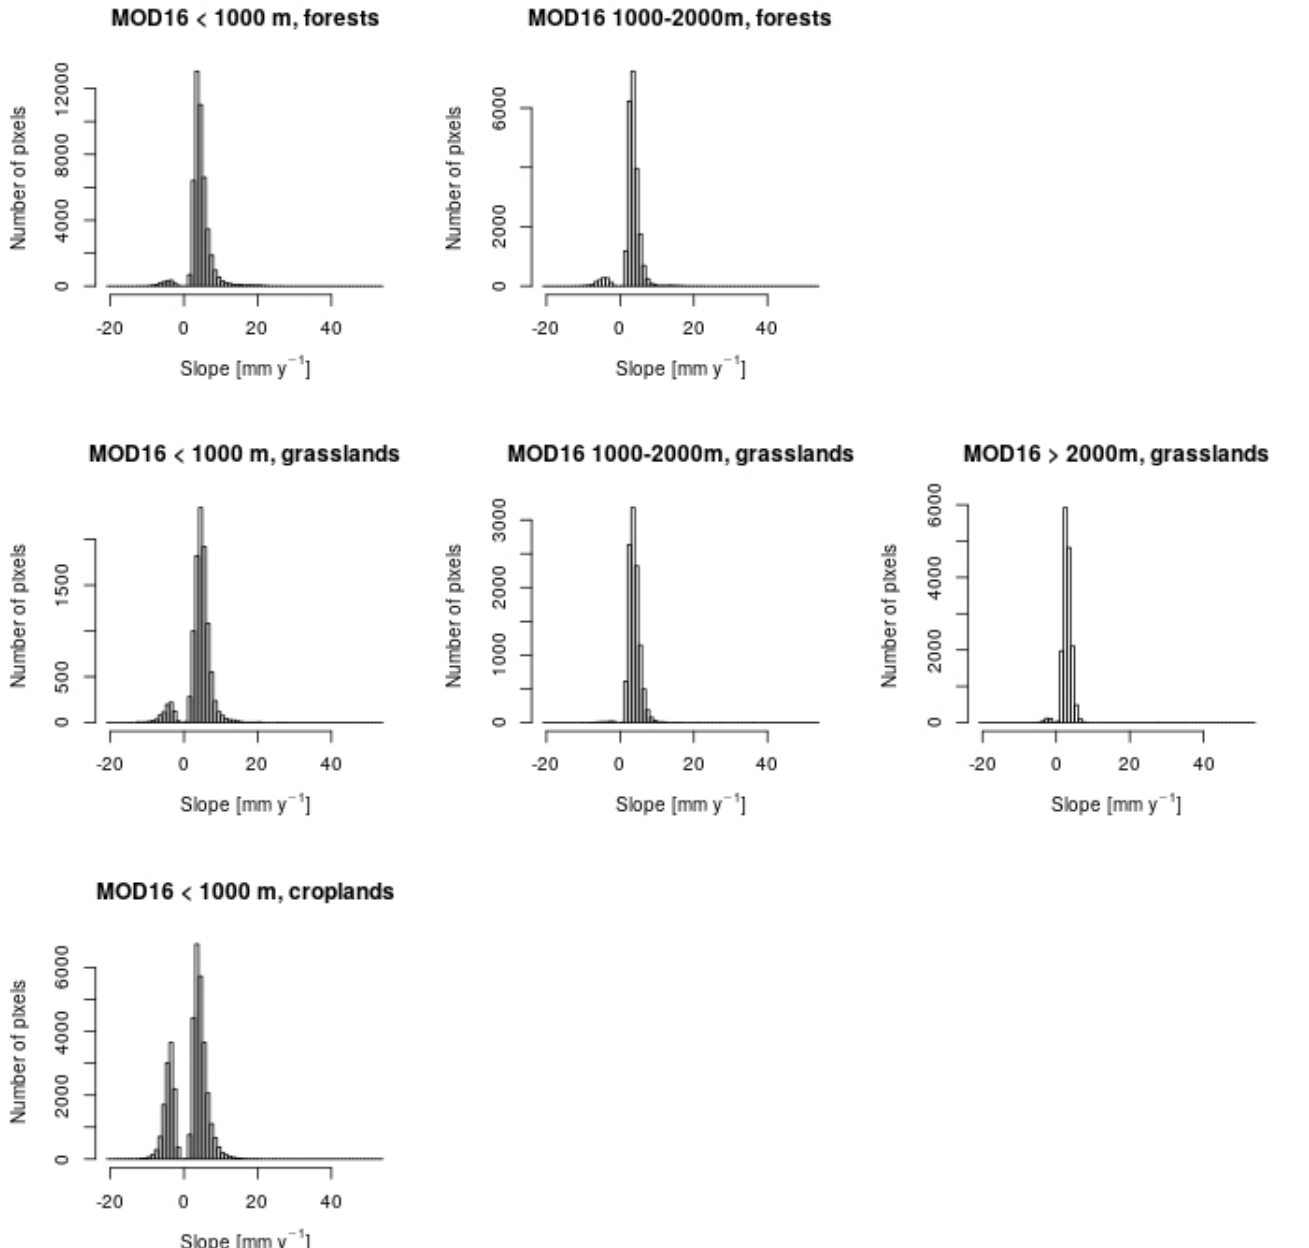
Figure 2. Histograms representing the distribution, within the land cover and elevation classes indicated in the titles, of the Sen’s slope of the trend of MOD16 yearly ET at 5% significance level. On the y axis there are 500 m × 500 m pixels.